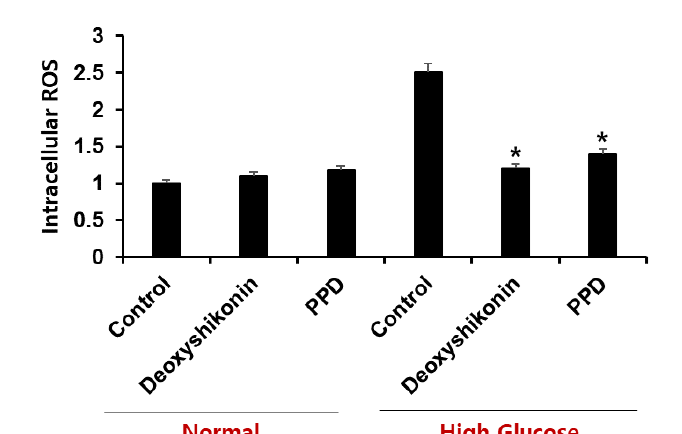
Figure 8. HUVECs were treated with deoxyshikonin (3 µ M) or PPD (12.5 µ M) for 48 h under normal or high glucose conditions, then cells were stained with dichlorofluorescein diacetate (DCF-DA). Deoxyshikonin was used as a positive control. ( A ) Fluorescence images of DCF-DA were captured using fluorescence microscopy. Scale bar, 50 µ m. ( B ) Bars represent a fold increase in fluorescence intensity of DCF-DA using microplate reader. Data are presented as the mean ± standard deviation (SD) of three independent experiments. * p < 0.05 compared to the control in high